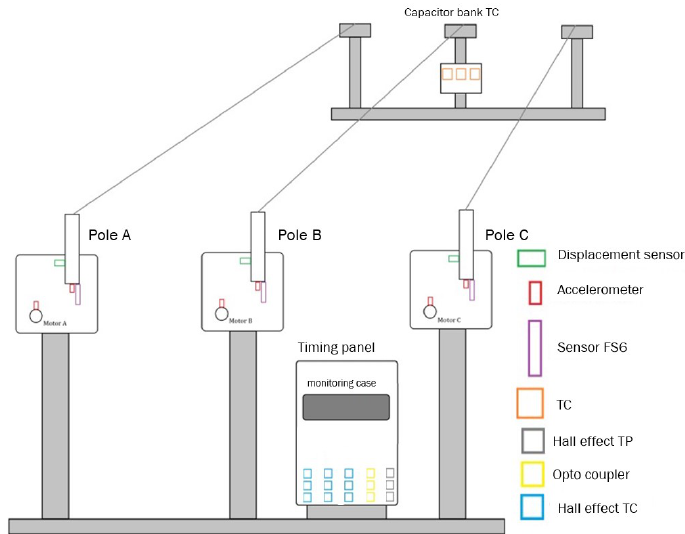
Figure 15. Locations of the monitoring system